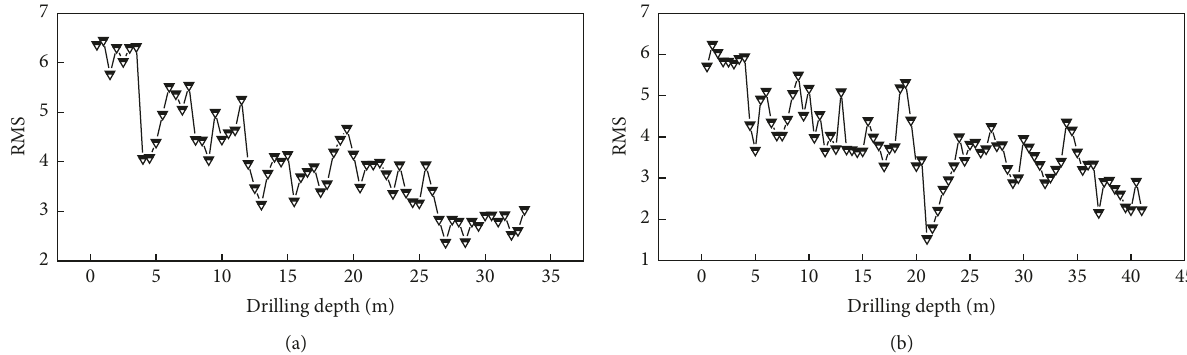
Figure 14: Distribution of RMS values for cross-layer boreholes: (a) borehole No. 11; (b) borehole No. 12.